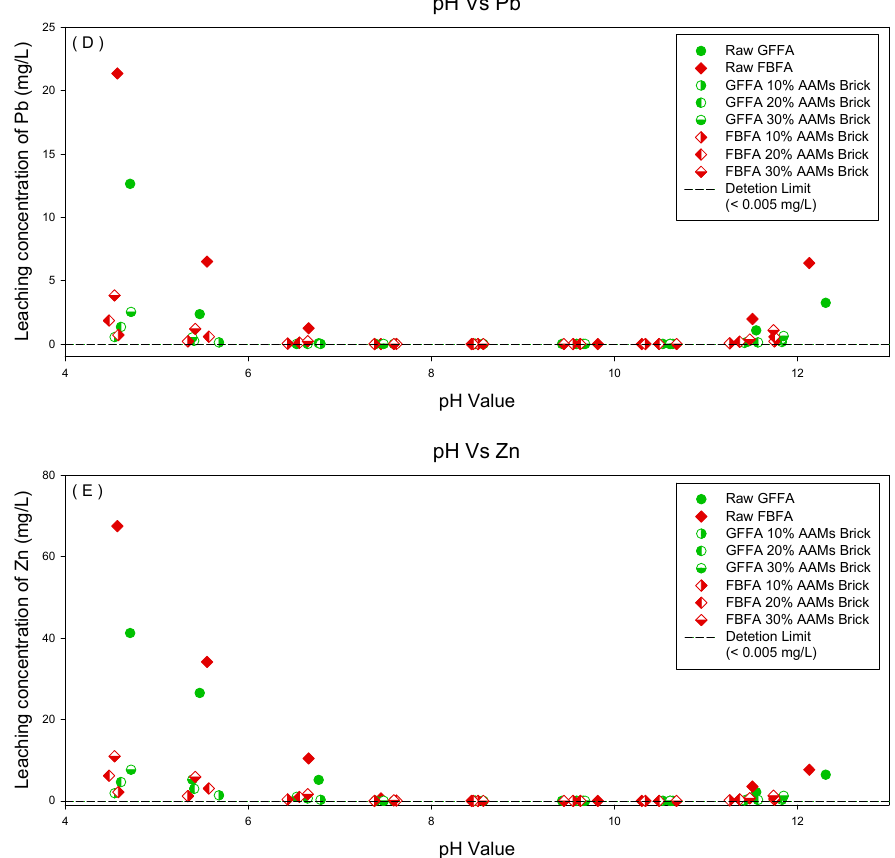
Figure 4. The results of raw GFFA, raw FBFA and MSWI-FA containing AAMs bricks using the leaching test in CEN/TS 14429. ( A ) Ba; ( B ) Cu; ( C ) Cr; ( D ) Pb; ( E ) Zn.